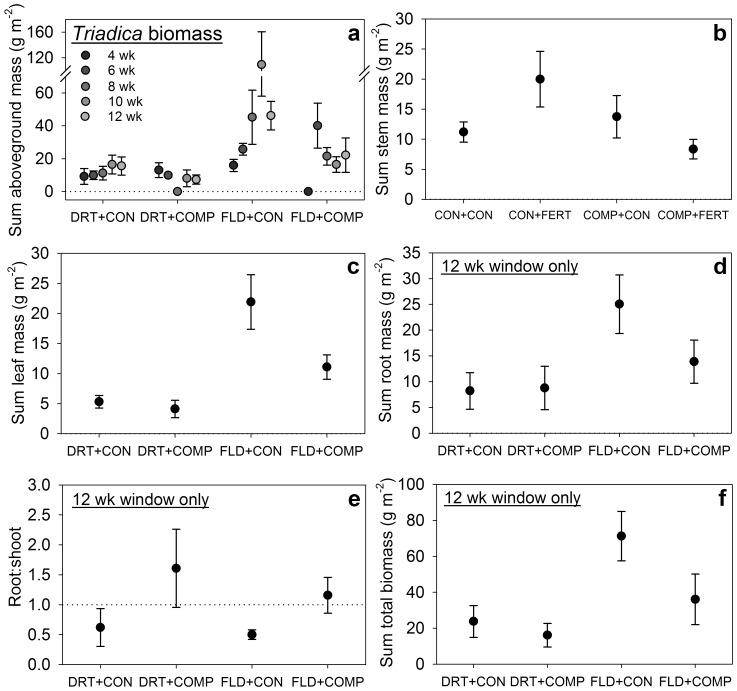
Effects of experimental treatments on six metrics of Triadica biomass.Panels (a–f) represent biomass metrics (means ±1 SE) broken down by treatments that significantly affected that metric (except in C where window effects are not show and E-G where insignificant trends are shown). Legend: stress type – drought (DRT) or flood (FLD); competition – natives added (COMP) or control (CON); fertilization – NPK added (FERT) or control (CON). Pot sums of aboveground biomass (a), stem biomass (b) and leaf biomass (c) were reduced in drought or competition treatments, and increased with fertilization without competition but decreased with fertilization with competition (e.g. panel b). Aboveground and leaf biomasses increased with window duration, but these relationships were inconsistent with competition (e.g. panel a). Competition reduced aboveground and leaf biomasses in flood only, but they were lowest in drought overall (e.g. panel c). Sums of root (d) and whole plant biomass (f) were lower in drought treatments. (f) Competition increased root:shoot ratios.